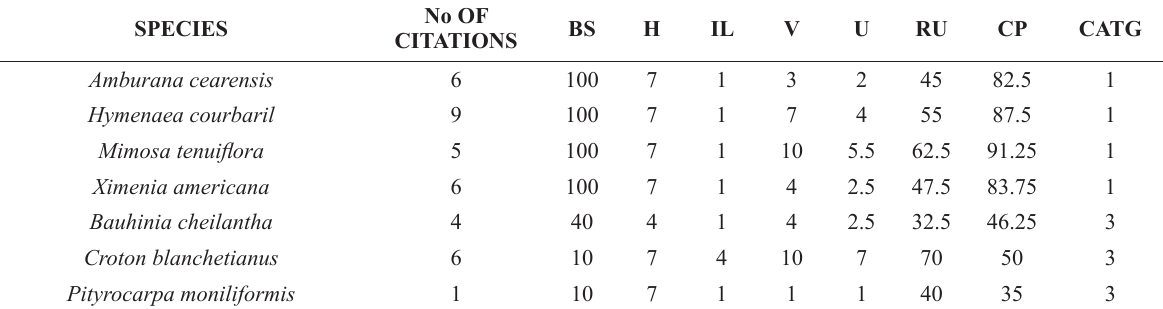
List of species indicated with local conservation priority in the vegetation of caatinga in Milagres-CE.